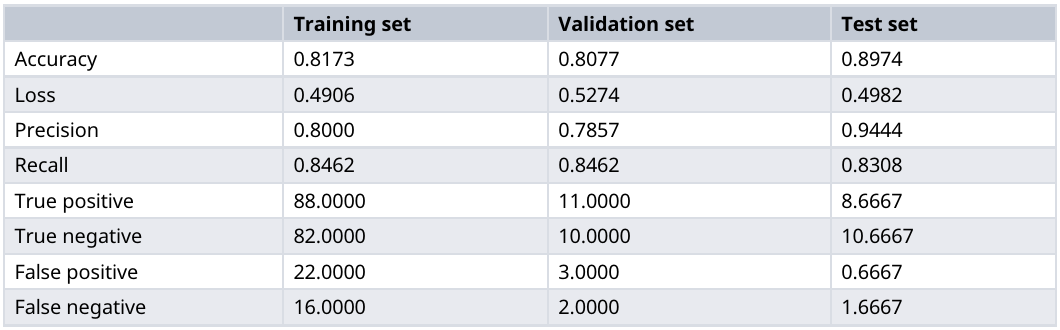
Table 2. Performance of newly defined classifier.